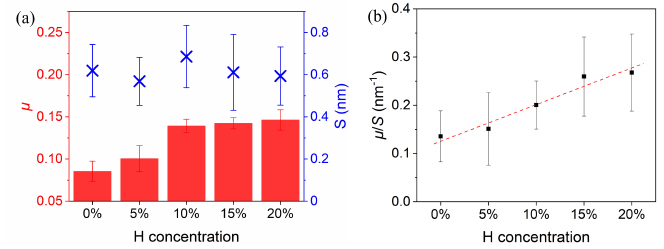
Figure 2. ( a ) Measured friction coefficient ( µ ) and surface roughness ( S ) of the FL-C:H films for various hydrogen concentrations. ( b ) The average ratio µ / S increases linearly with the hydrogen concentration.